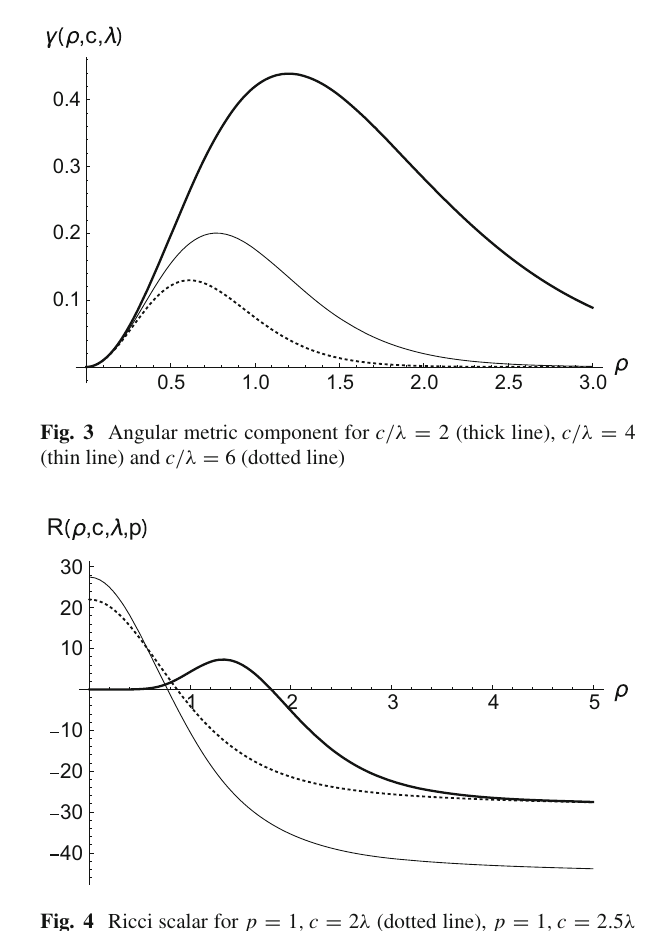
Fig. 4 Ricci scalar for p = 1 , c = 2 λ (dotted line), p = 1 , c = 2 . 5 λ (thin line) and c = 2 λ and p = 10 (thick